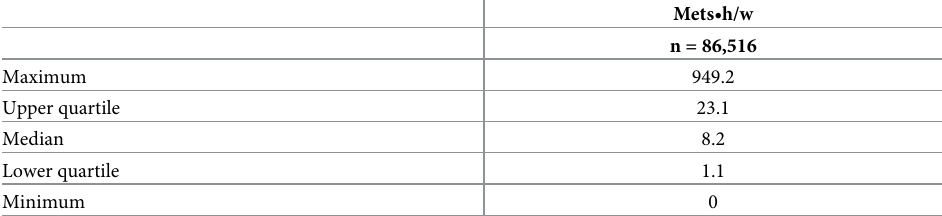
Table 1. Amounts of physical activity during pregnancy